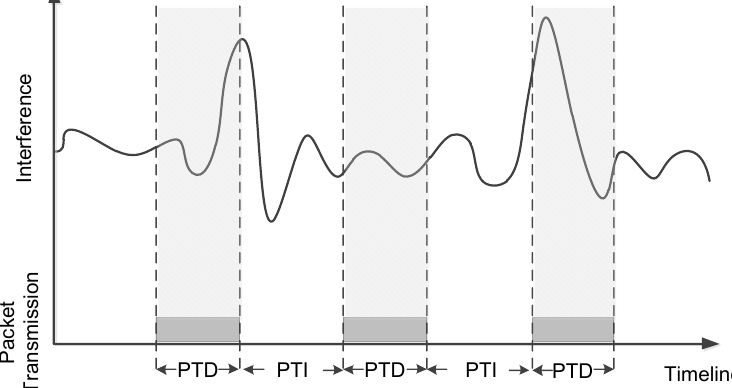
Figure 1. An example to illustrate the impacting factors of link correlation. PTD, packet transmission duration; PTI, packet transmission